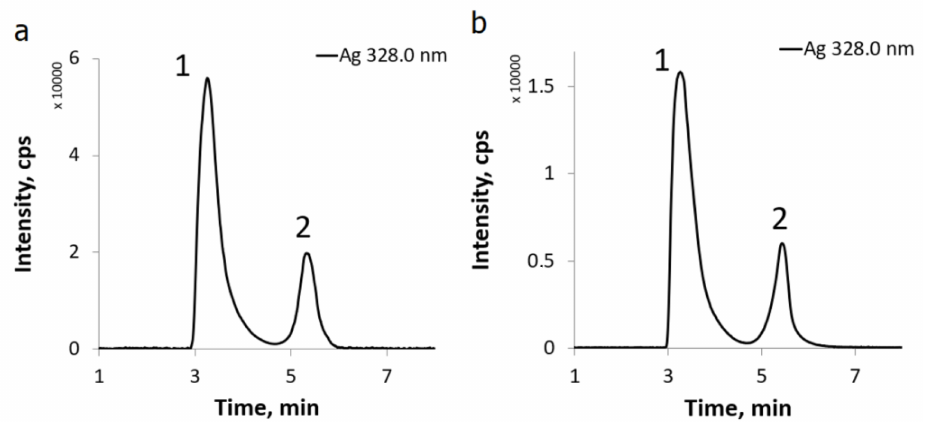
Figure 4. The HPLC-ICP-AES chromatogram of the Ag clusters in coordinates “retention time– line intensity”: ( a ) fresh solution of AgNO 3 and AgS t Bu in DMSO, ( b ) after 8 h. Peaks No.1 and No.2 correspond to silver clusters containing 19 and 20 atoms,